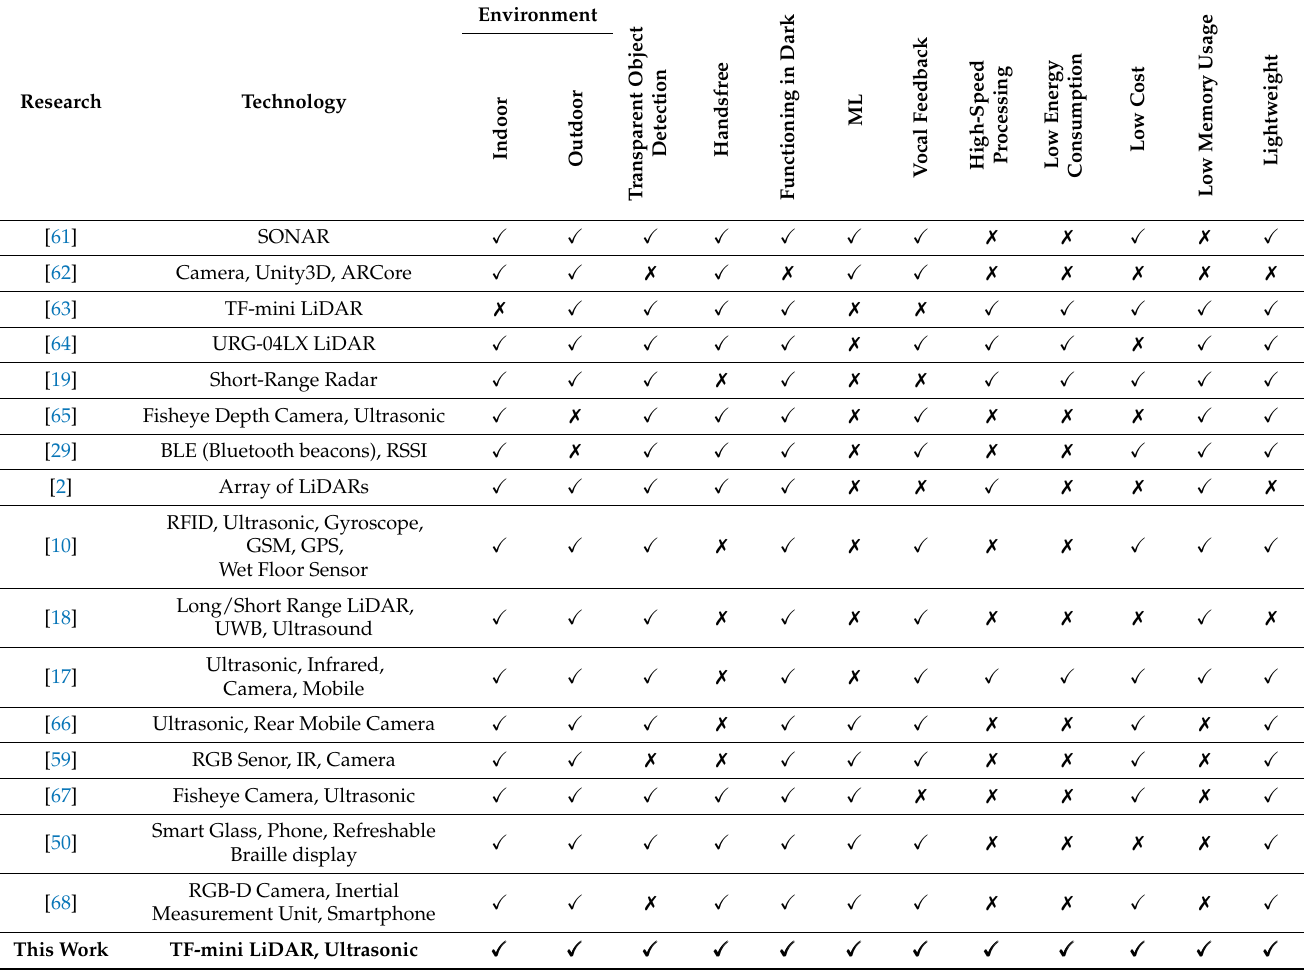
Table 2. Summary of the relevant works and a comparison with the proposed